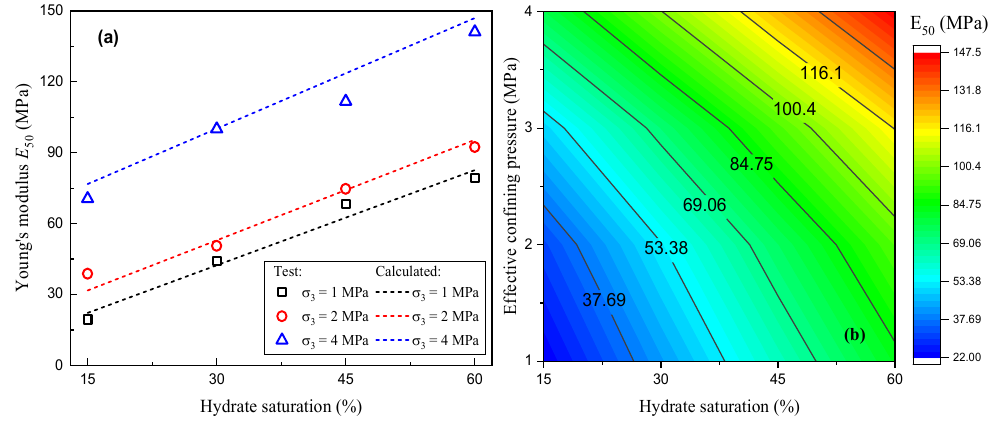
Figure 12. Prediction of Young’s modulus: ( a ) Comparison between calculated and test results; ( b ) Prediction of Young’s modulus based on the proposed empirical equation.